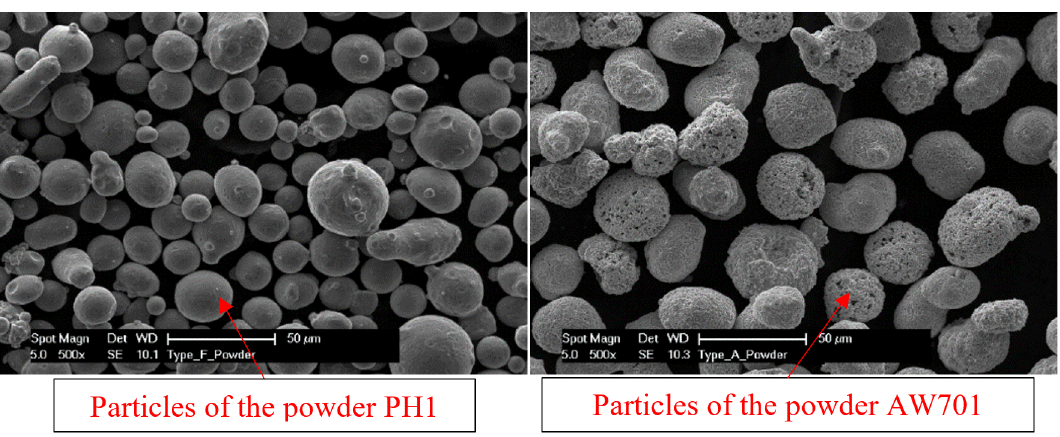
Figure 1. The shape of particles of AW701 powder mixture and PH1 steel powder.